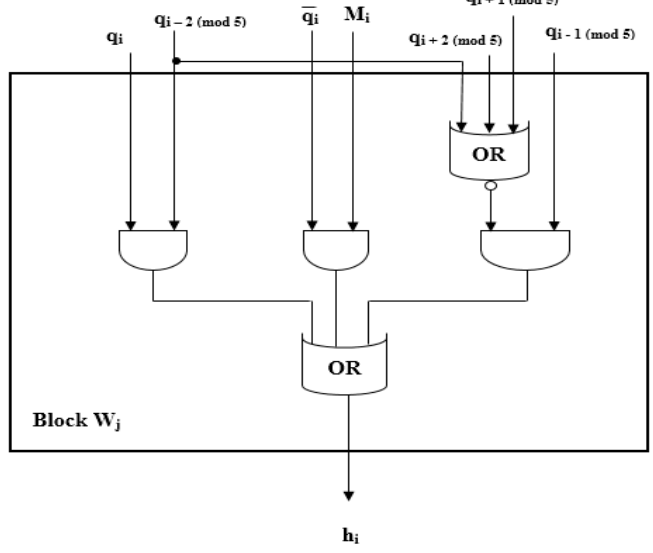
Figure 7. Logic diagram of Block W j .